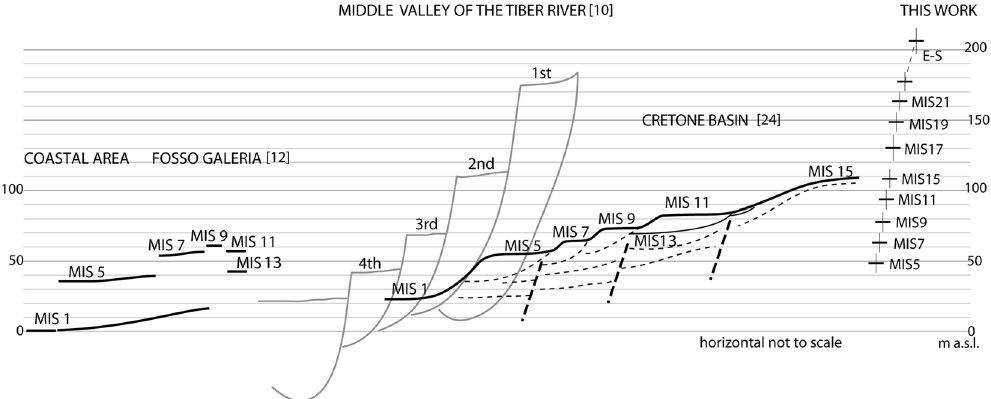
Figure 3. Comparative terrace dataset. Elevation of the terraced surfaces in the coastal area of Rome 12 and in the Cretone Basin 24 , which are correlated with the MISs through geochronologic constraints, are used as comparative datasets for the paleo-surfaces reconstructed in this work. Comparison with previous work by 10 is also shown. In comparing these data it must be considered that elevation range for the terraces reconstructed by 9 is estimated in a much longer portion of the Tiber Valley, accounting for a larger downstream gradient (see text for further